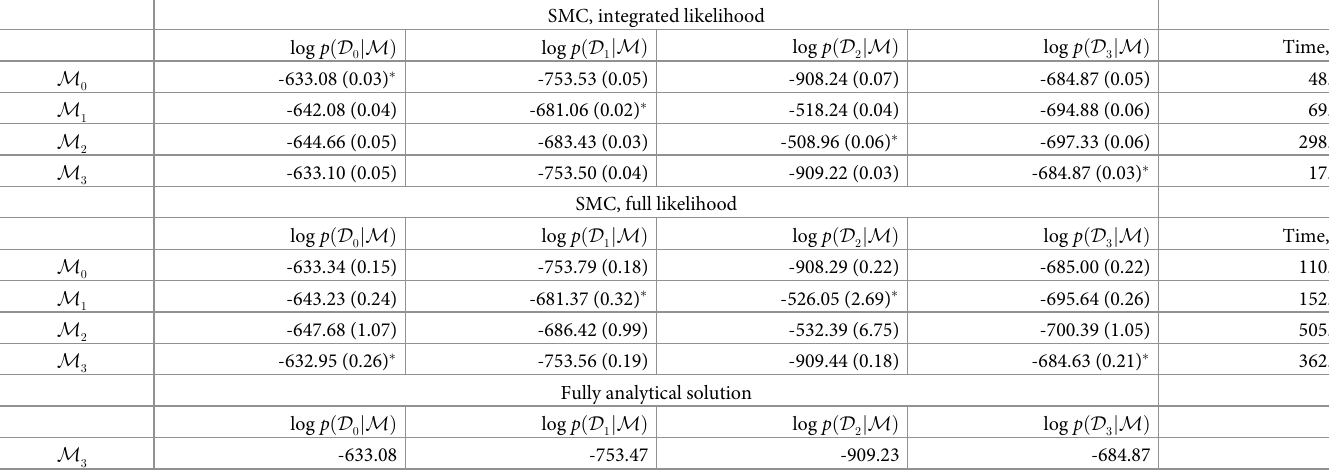
with rounding here, but see 3